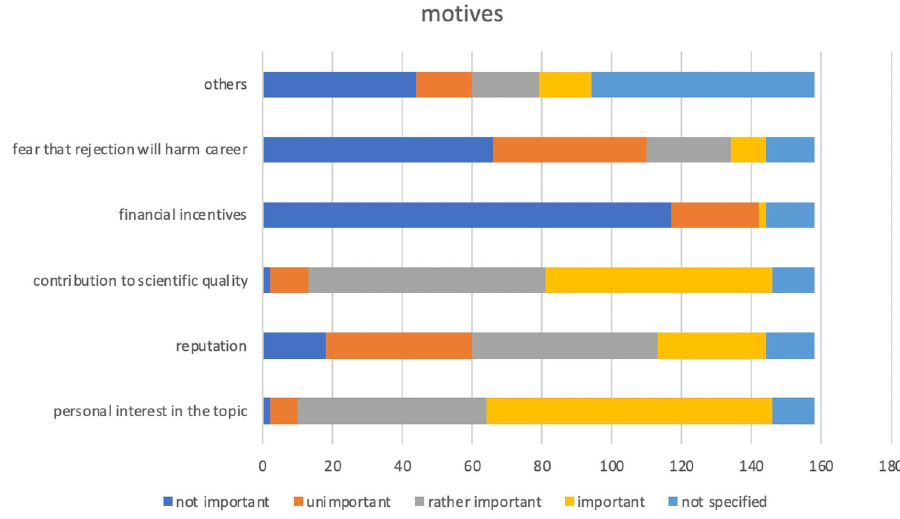
Fig 3. Intrinsic motivation for reviewing. The bars indicate the number of individuals rating the different motives according to their personal importance.